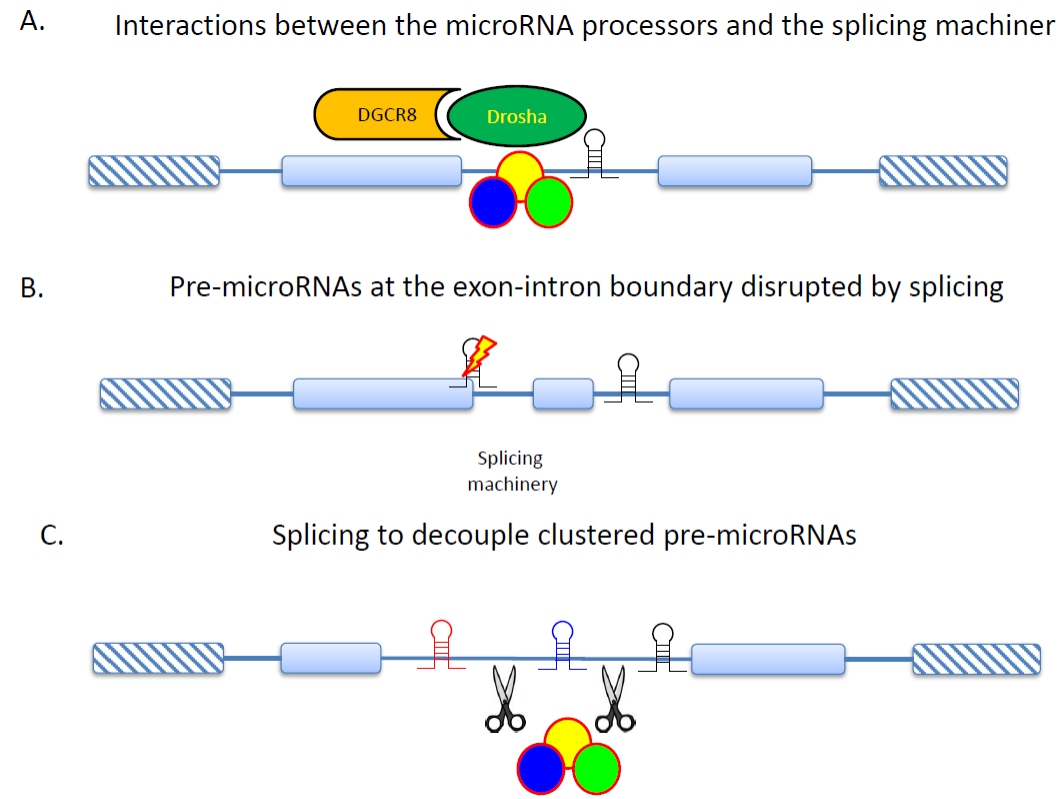
Figure 5. Connections between AS and the biogenesis of intronic microRNAs. ( A ) microRNA processors interact with the splicing machinery and participate in RNA splicing; ( B ) Splicing can disrupt the biogenesis of microRNAs that are located at the exon-intron boundaries; ( C ) Splicing can serve to delineate microRNAs that are clustered in an